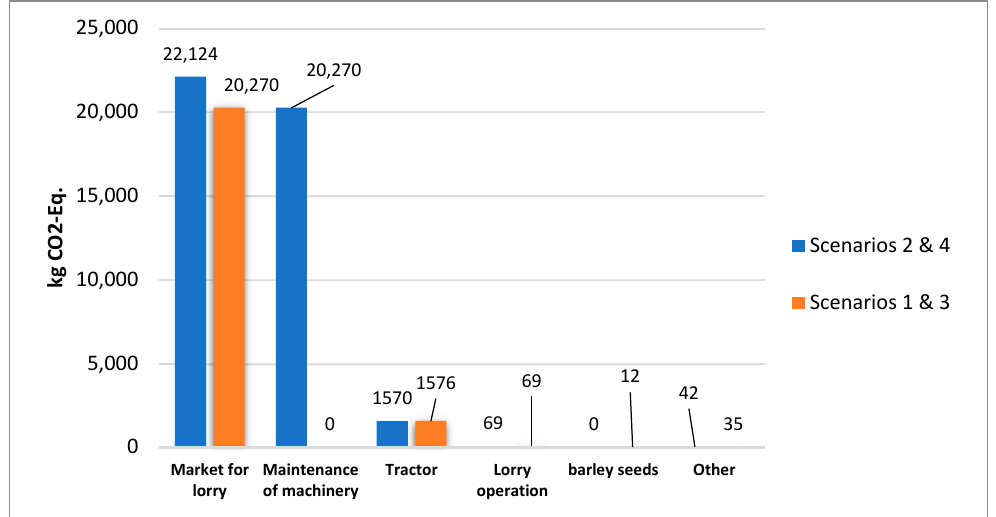
Figure 7. Six highest impact processes according to the results of the OpenLCA in kg CO 2 -Eq ∙ FU − 1 for the measurement of GWP.